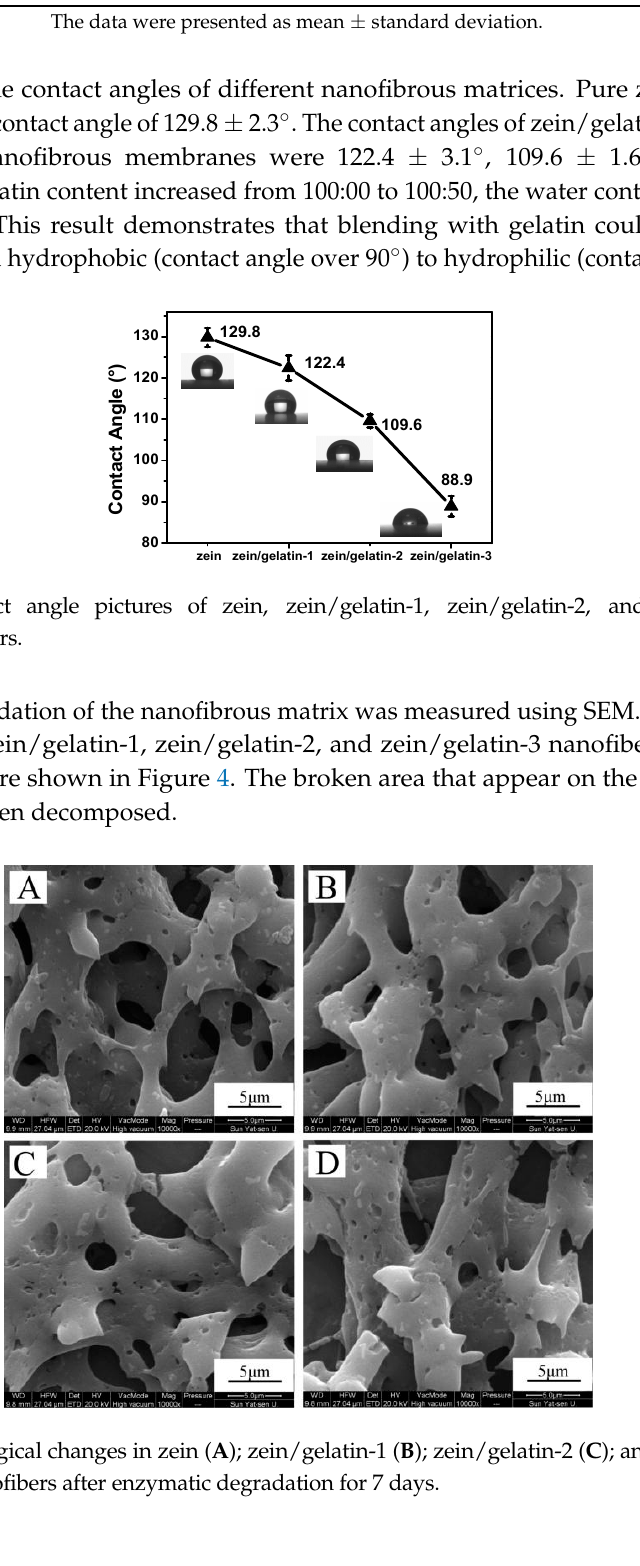
Table 1. Mechanical properties of electrospun zein/gelatin nanofibers with different compositions. Sample